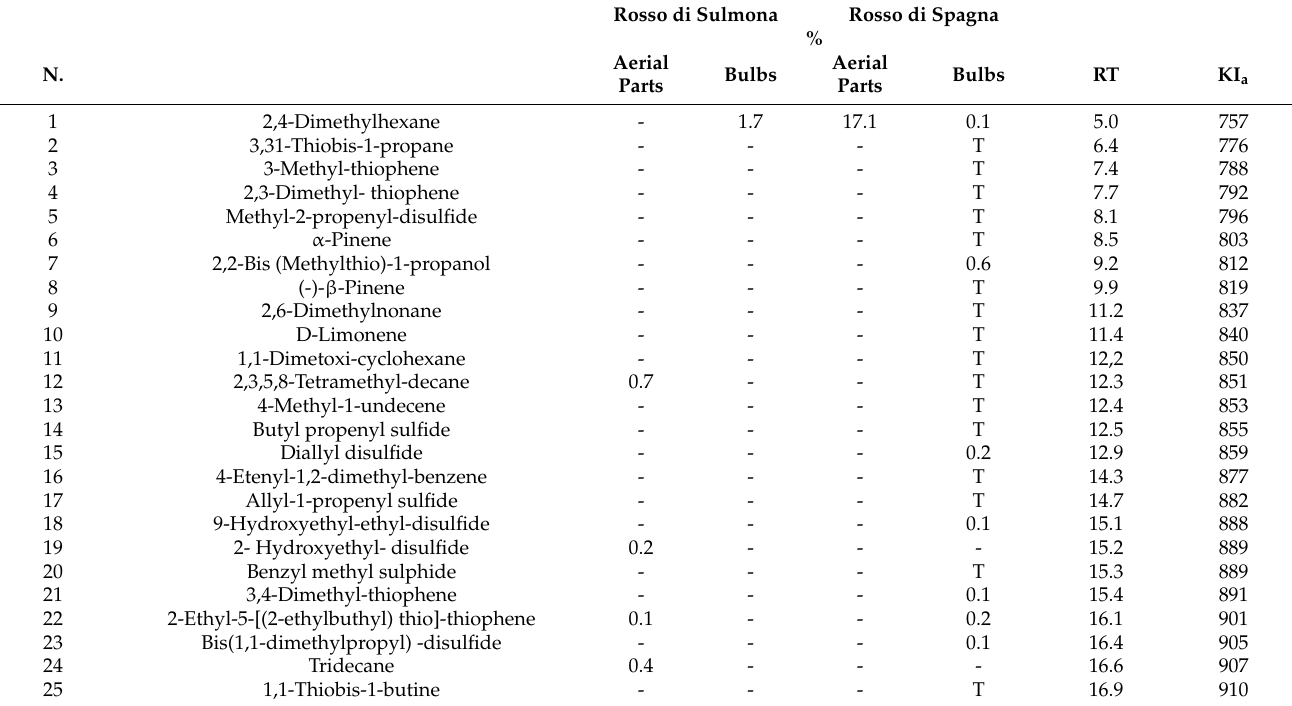
Table 3. Chemical composition of the EOs of A. sativum, cultivars ‘Rosso di Sulmona’ and ‘Rosso di